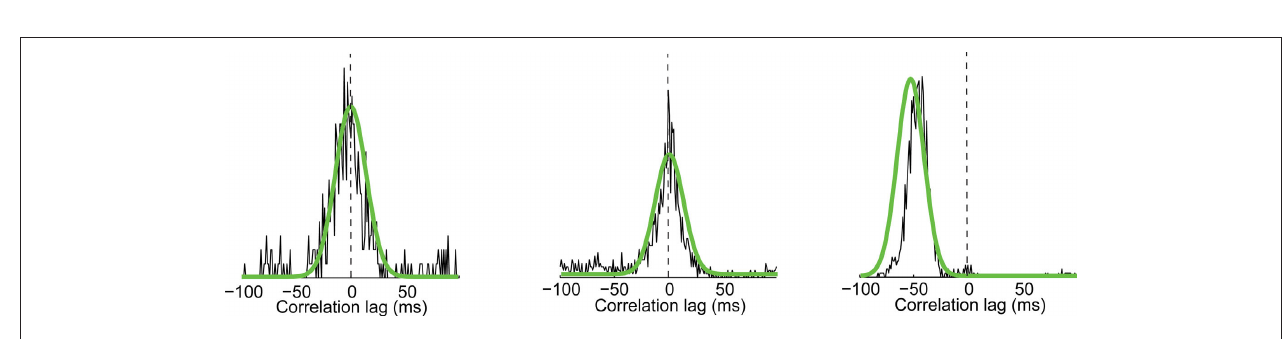
different pairs of cells. Superimposed in green are the predictions of the GLM model for 10,000 repeats simulating the same three pairs at those particular